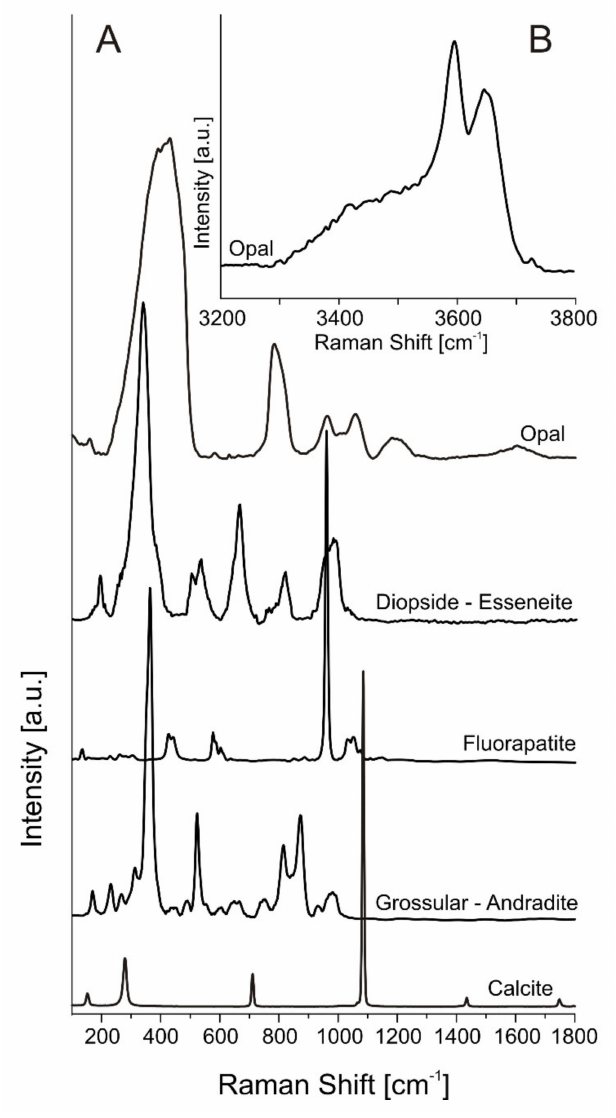
Figure 5. Raman spectrum of major mineral phases in the zeolite-bearing rock. Raman spectra of opal are represented in two figures within the range 0–1800 ( A ) and 3200–3800 cm − 1 ( B